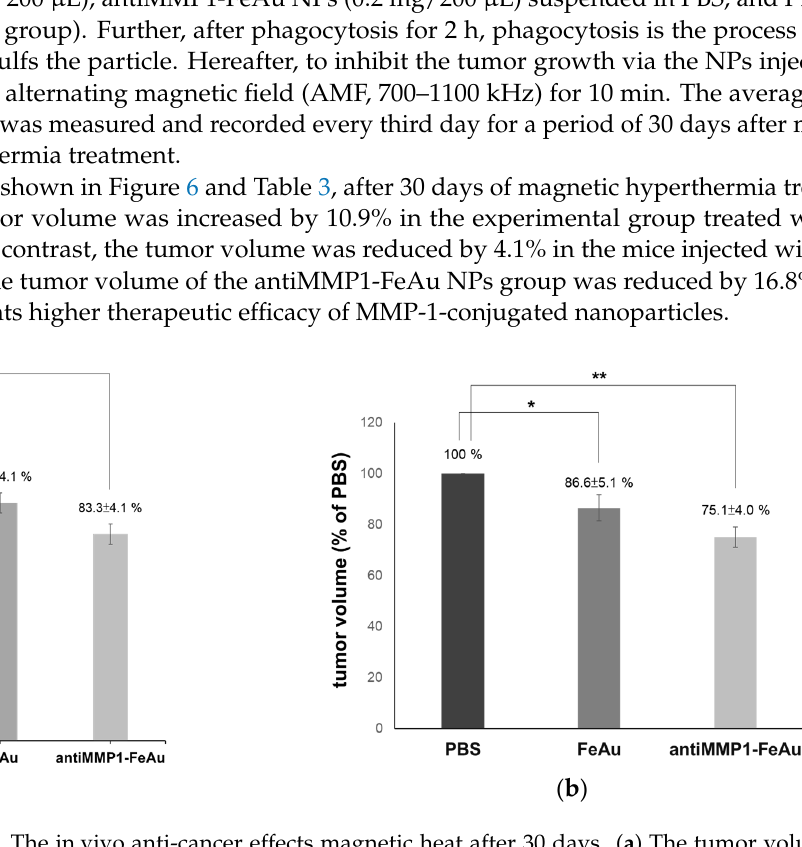
Figure 5. Cell responses of FeAu NPs and MMP-1 antibody-conjugated FeAu NPs. ( a ) Cellular via- bility of L929 and HSC-3 by the MTT assay (n = 3); ( b ) bio-TEM micrographs of human oral squa- mous carcinoma incubated with FeAu and MMP1-FeAu over different time periods; ( c ) quantifica- tion of cellular uptake of FeAu NPs and MMP1-FeAu NPs in HSC-3 cells and L929 cells analyzed by ICP-AES, ( d ) FeAu NPs and MMP1-FeAu NPs stimulated magnetically.